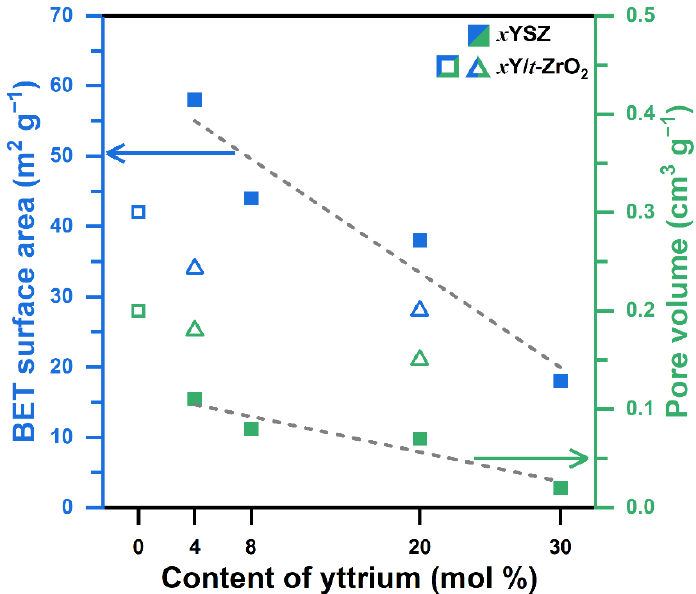
Figure 1. BET surface areas and the pore volumes of the co-precipitated xYSZ (filled squares) and impregnated x Y/ t -ZrO 2 (open triangles) catalysts along with bare t -ZrO 2 (open squares).